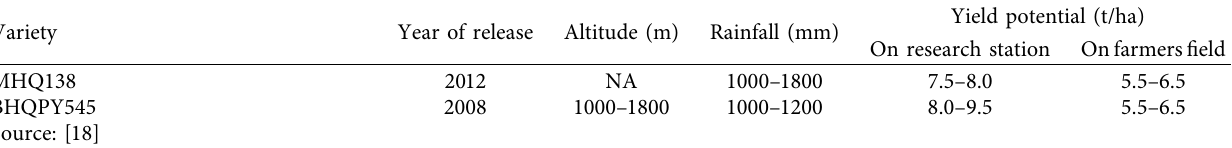
Table 2: Experimental materials used in the